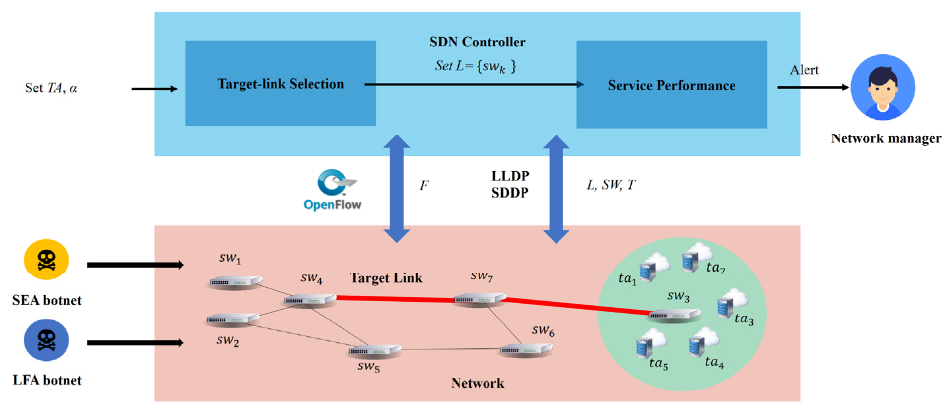
Figure 2. FDD process schematic diagram.